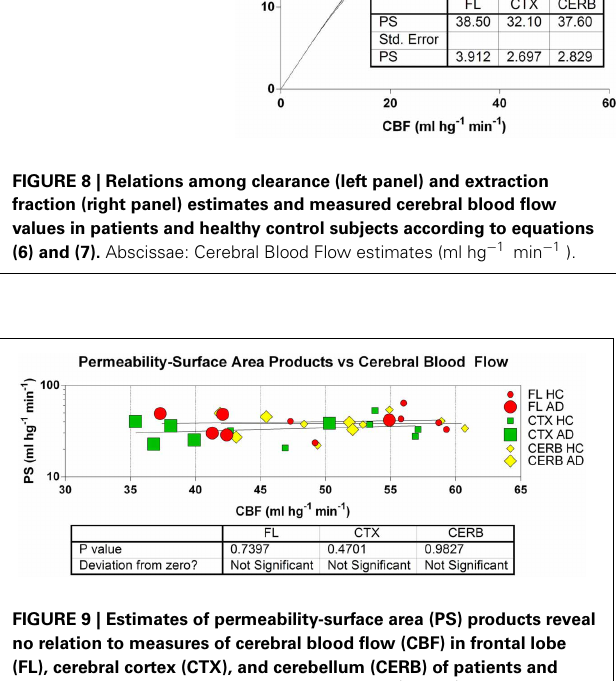
FIGURE 9 | Estimates of permeability-surface area (PS) products reveal no relation to measures of cerebral blood flow (CBF) in frontal lobe (FL), cerebral cortex (CTX), and cerebellum (CERB) of patients and healthy control subjects. Abscissa: CBF (ml hg − 1 min − 1 ). Ordinate: PS products (ml hg − 1 min − 1 ). Absent correlation is consistent with incomplete flow-limitation of blood-brain transfer of [ 11 C ] PiB.